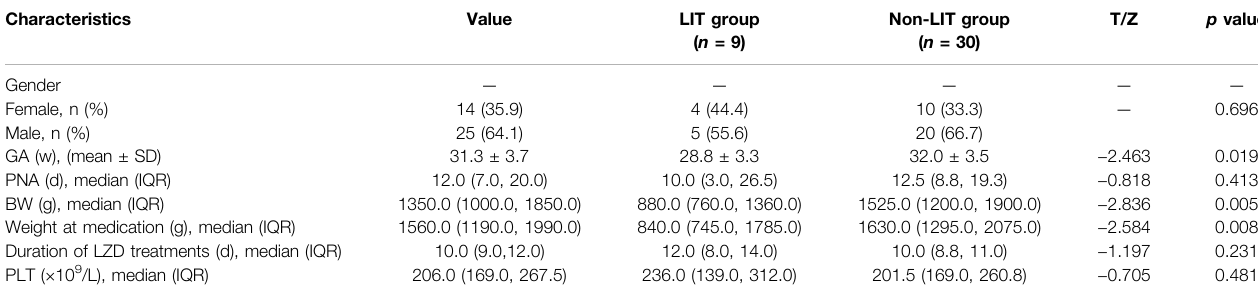
TABLE 2 | General clinical data of patients. Characteristics